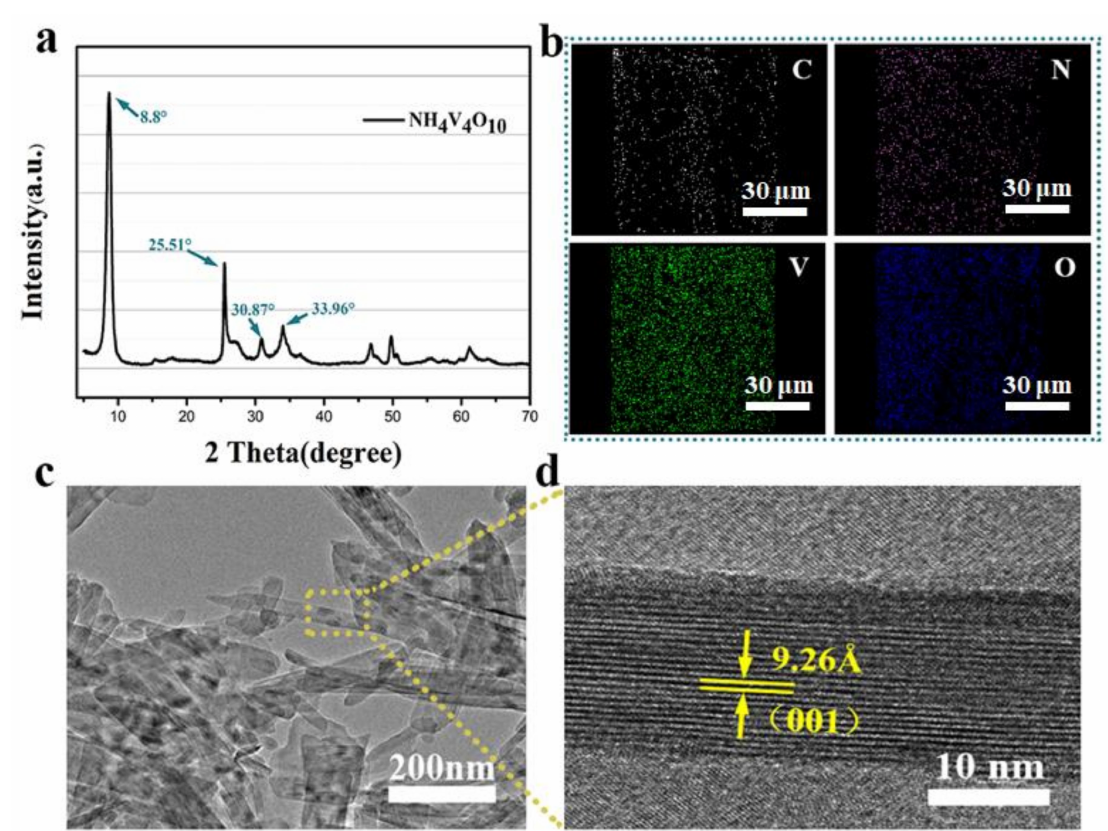
Figure 3. ( a ) X-ray diffraction (XRD) pattern; ( b ) EDS mapping of C, N, V, and O; ( c ) transmission electron microscopy (TEM) images; ( d ) HRTEM images of NH 4 V 4 O 10 at different